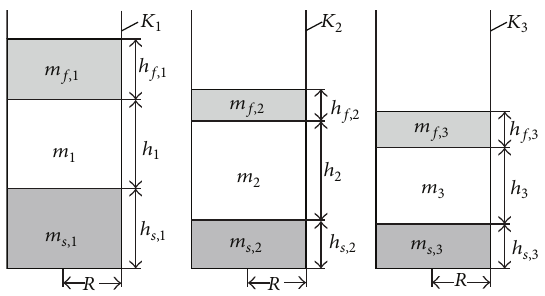
Figure 2: Vertical axial section of three equal straight cylindrical containers with separated components of liquid